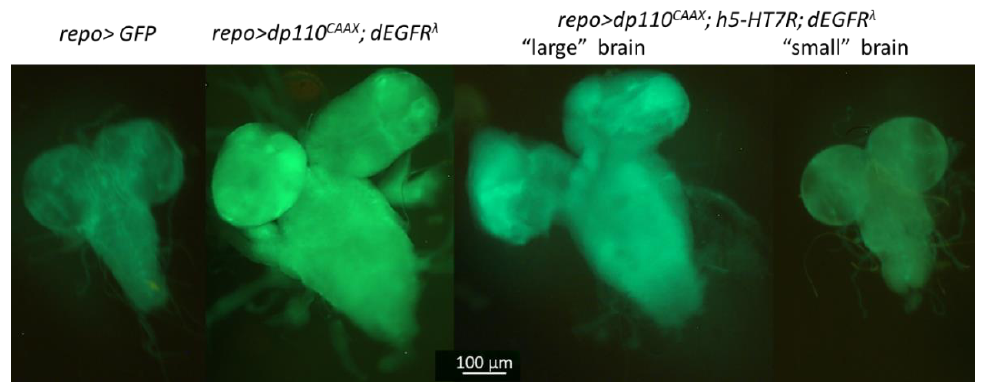
Figure 5. h5-HT7R expression reduces proliferation in glioma. Fluorescence microscopy images of third instar larval brains. Larvae expressing h5-HT7R in a glioma context (repo>dp110 CAAX ; h5-HT7R; dEGFR λ ) exhibit brains of different sizes: “large” brains look like glioma (repo>dp110 CAAX ; dEGFR λ ), “small” brains look like controls (repo>GFP). Green fluorescent protein (GFP) is expressed in glial cells.